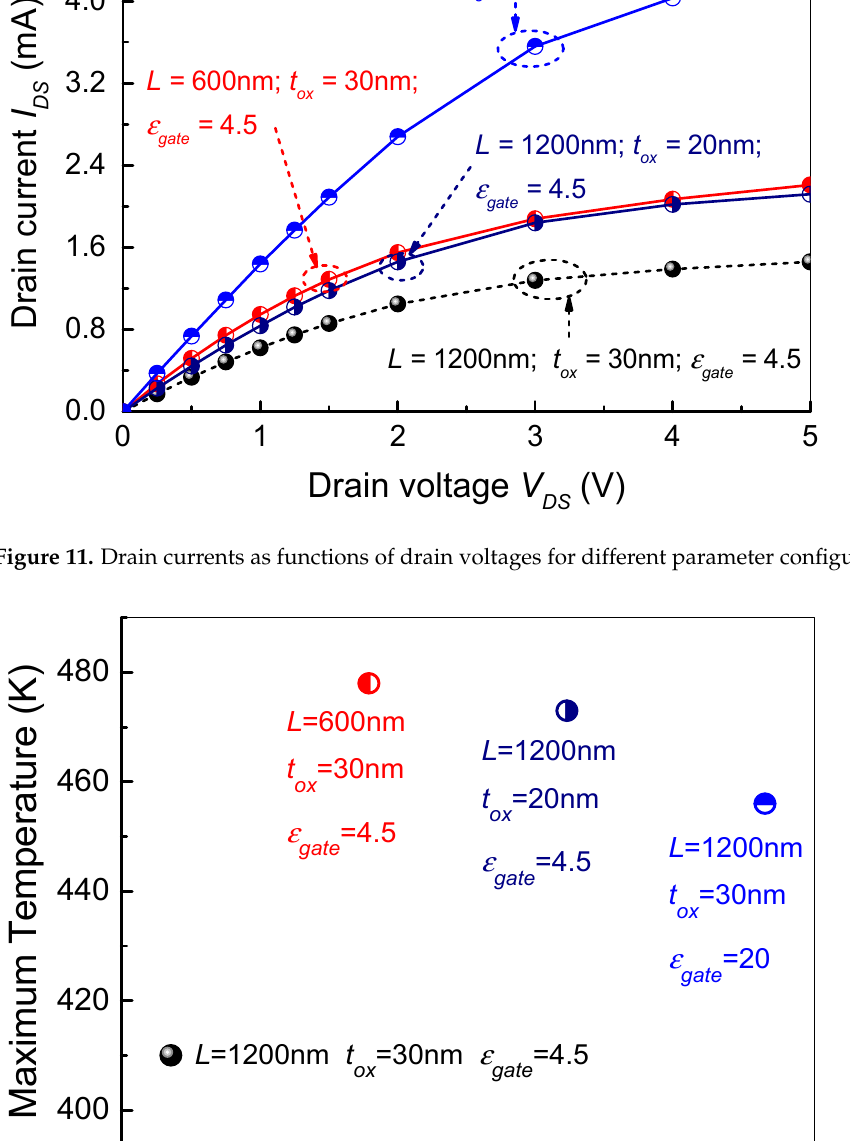
Figure 12. Maximum temperatures in vertical MOSFET with different parameter configurations.